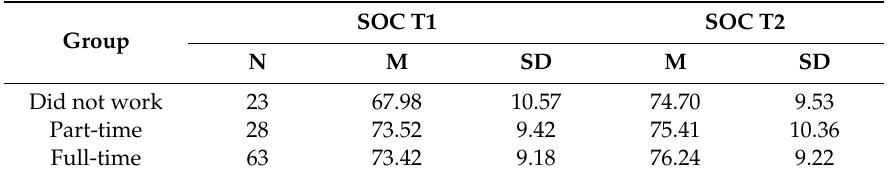
Table 3. Sense of coherence level at T1 (SOCT1) and T2 (SOCT2) divided by job status before the birth. SOC T1 SOC Group